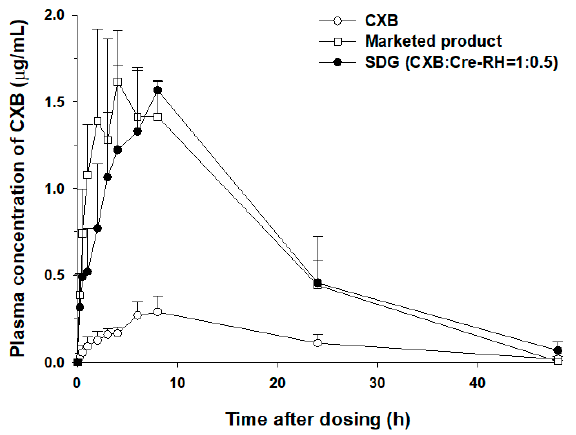
Figure 5. Plasma concentration versus time profiles of CXB in Sprague Dawley (SD) rats after oral administration of CXB, the marketed product (Celebrex ® ), and SDGs (CXB/Cre-RH = 1:0.5) at a dose of 5 mg/kg ( n = 4–5). Table 3. Pharmacokinetic parameters of CXB in SD rats after oral administration of an equivalent dose (5 mg/kg) of CXB powder, the marketed product (Celebrex ® ), or SDGs (CXB/Cre-RH = 1:0.5) ( n = 4– 5).